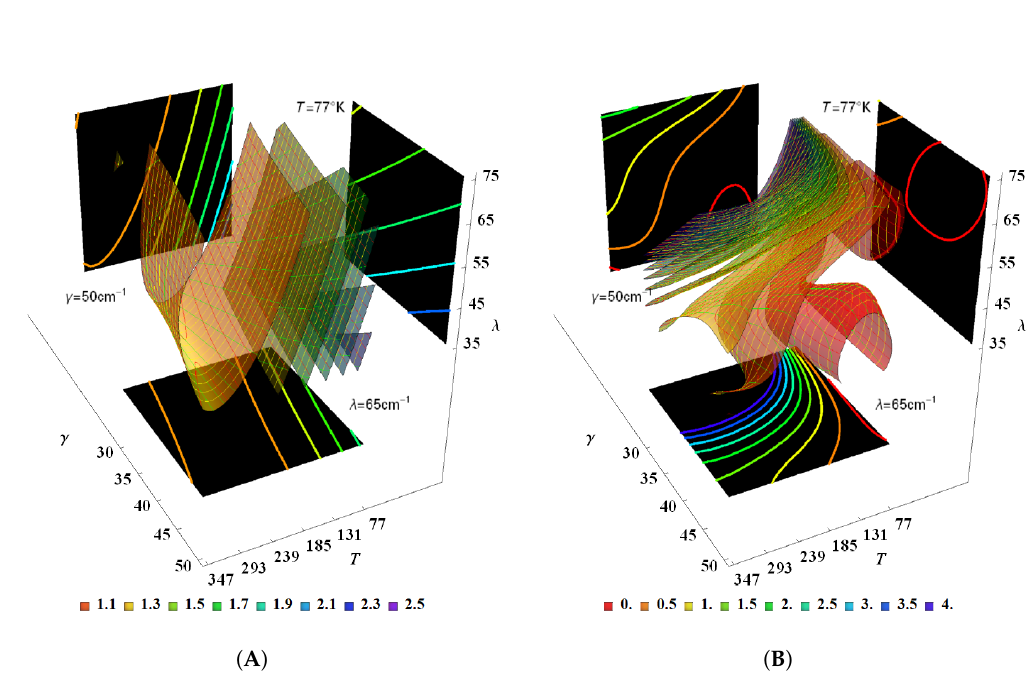
( ρ ) in the entire dynamics, and ( B ) half-life coherence time T 1